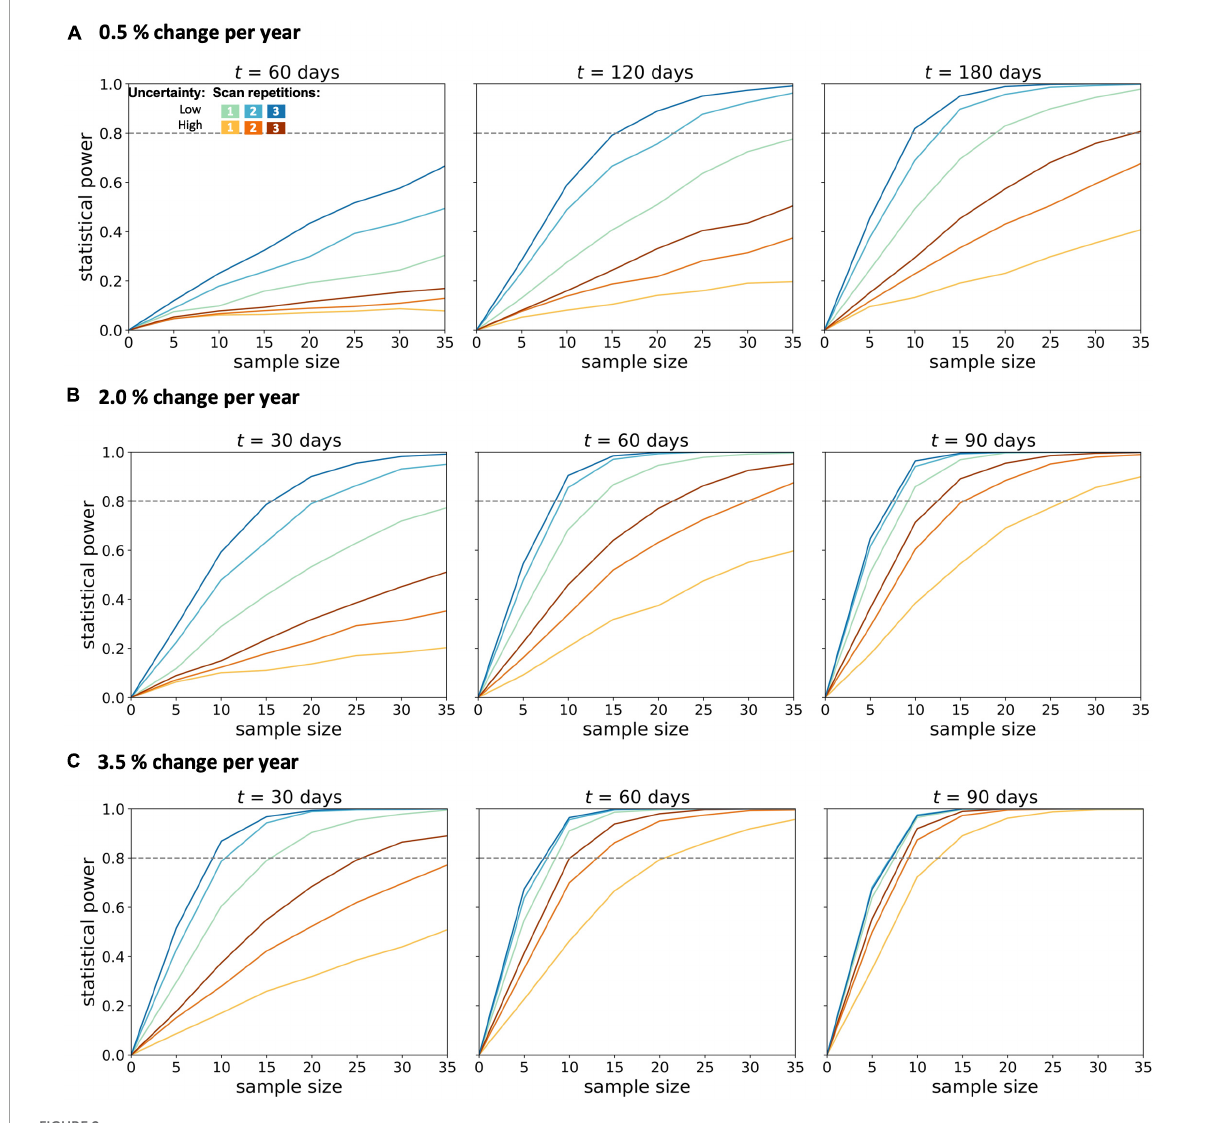
FIGURE2 Statistical power for longitudinal diffusion tensor imaging studies in amyotrophic lateral sclerosis. Calculations were performed for (A) 0.5%, (B) 2.0%, and (C) 3.5% change per year of the fractional anisotropy in the corticospinal tract. Longitudinal simulations for a patient and a healthy control group were performed for different sample sizes per group, two magnitudes of measurement uncertainty, one to three scans per session, and time intervals t between baseline and the follow-up